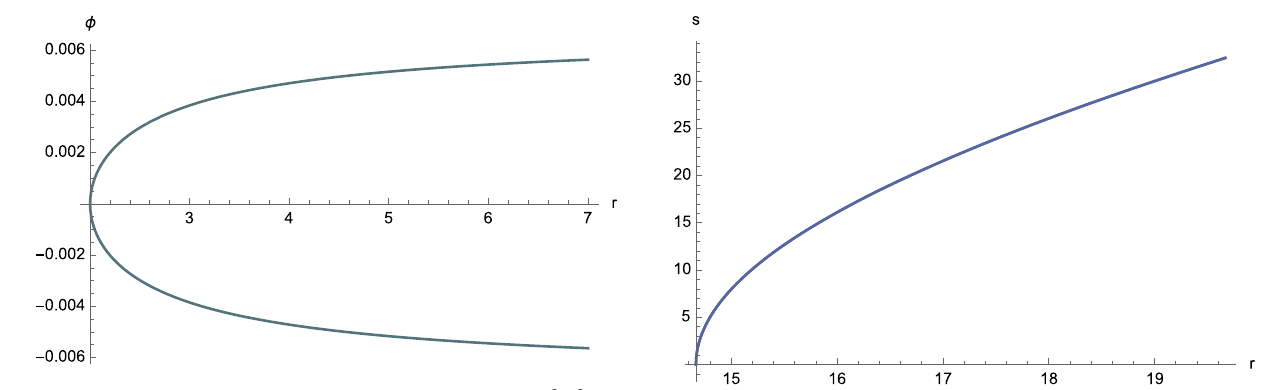
Fig. 13 The function φ = φ( r ) for first-kind orbits having C 2 E 2 < 1 in the limiting case (4.12). The following constants have been chosen: φ